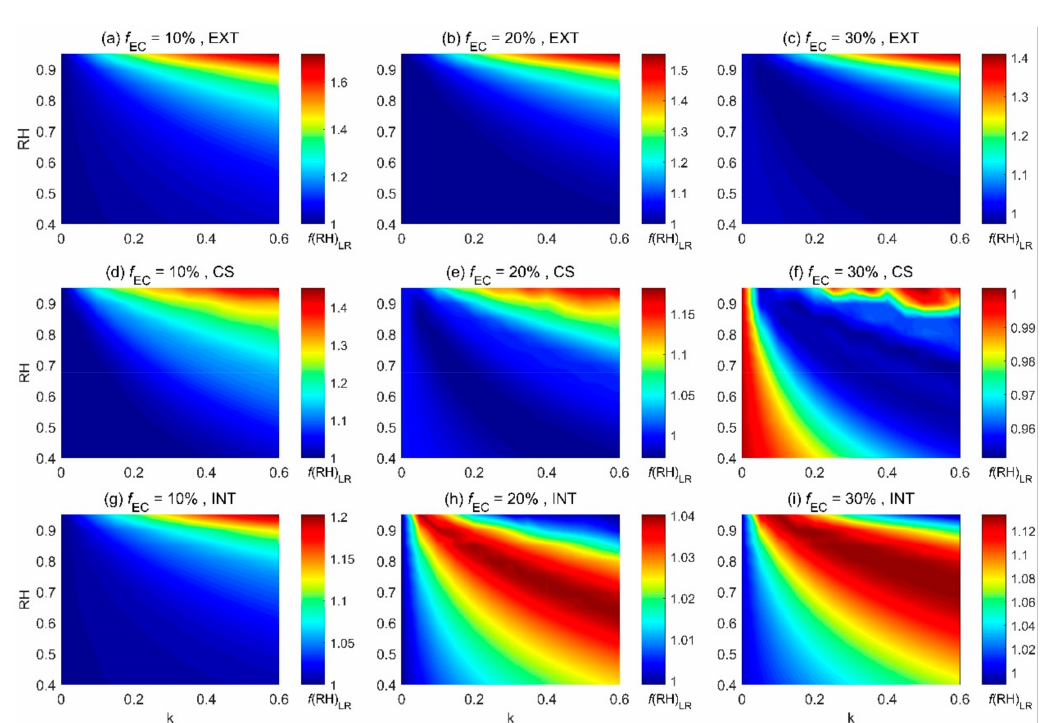
Figure 8. The LR under different κ and f EC values. The X axis represents κ , Y axis represents RH , and color represents the value of the f ( RH ) LR . ( a – c ) represent the EXT cases where the fractions of EC are 10%, 20% and 30%, respectively. ( d – f ) represent the CS cases where the fractions of EC are 10%, 20% and 30%, respectively. ( g – i ) represent the INT cases where the fractions of EC are 10%, 20% and 30%,